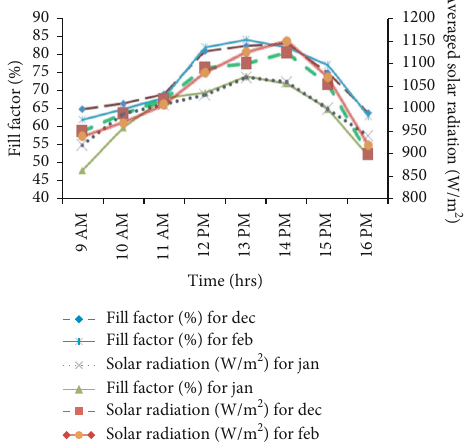
Figure 13: Performance characteristics curve for SPV system with the e ff ect of solar radiation [174].